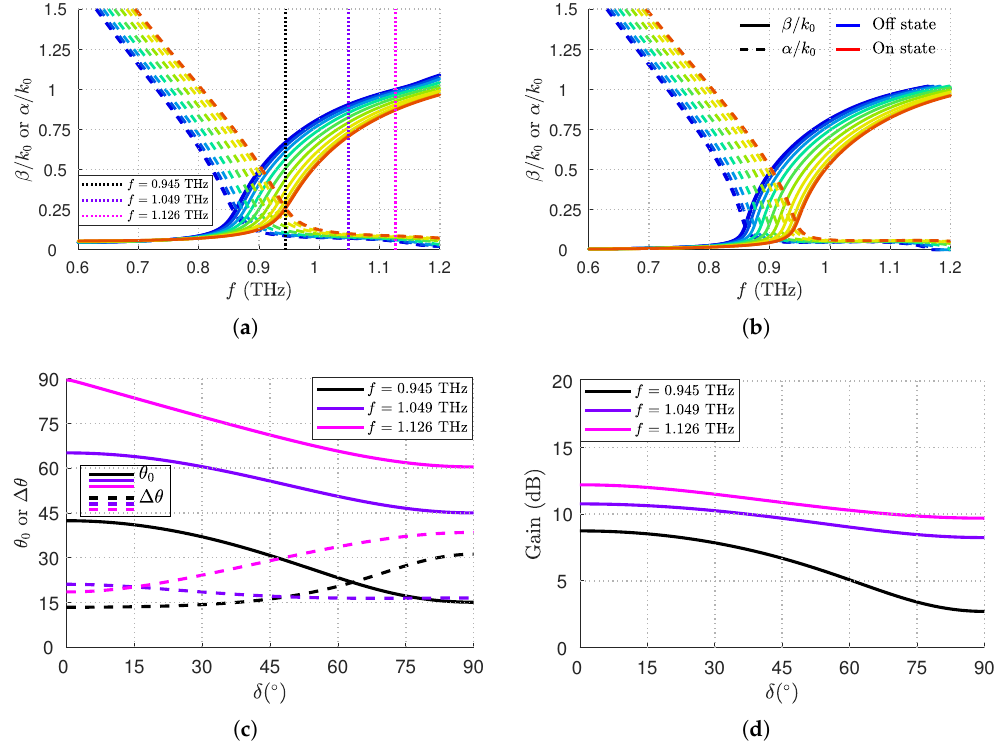
Figure 3. ( a , b ) Dispersion curves ˆ β (solid lines) and ˆ α (dashed lines) vs. f for NLC states continuously varying from the ‘off’ (blue) to ‘on’ state (red). The results in ( a , b ) are for the lossy and lossless cases, respectively. Dotted vertical colored lines highlight the frequency at which the antenna performance shown in ( c , d ) are evaluated. ( c ) The beam angle θ 0 (in solid lines) and half-power beamwidth ∆ θ (in dashed lines), and ( d ) gain G as the optical axis δ tilts from the horizontal z -axis δ = 0 ◦ to the vertical x -axis ( δ = 90 ◦ ) for the frequencies shown in ( a